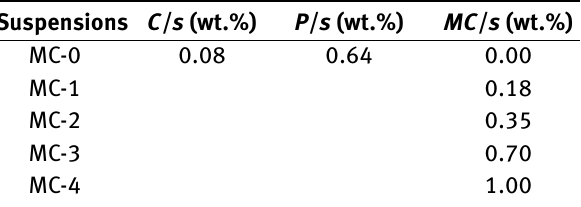
Table 2: Mass concentrations of MWCNTs, PC and MC in the pre- pared MC-MWCNT suspensions Suspensions C / s